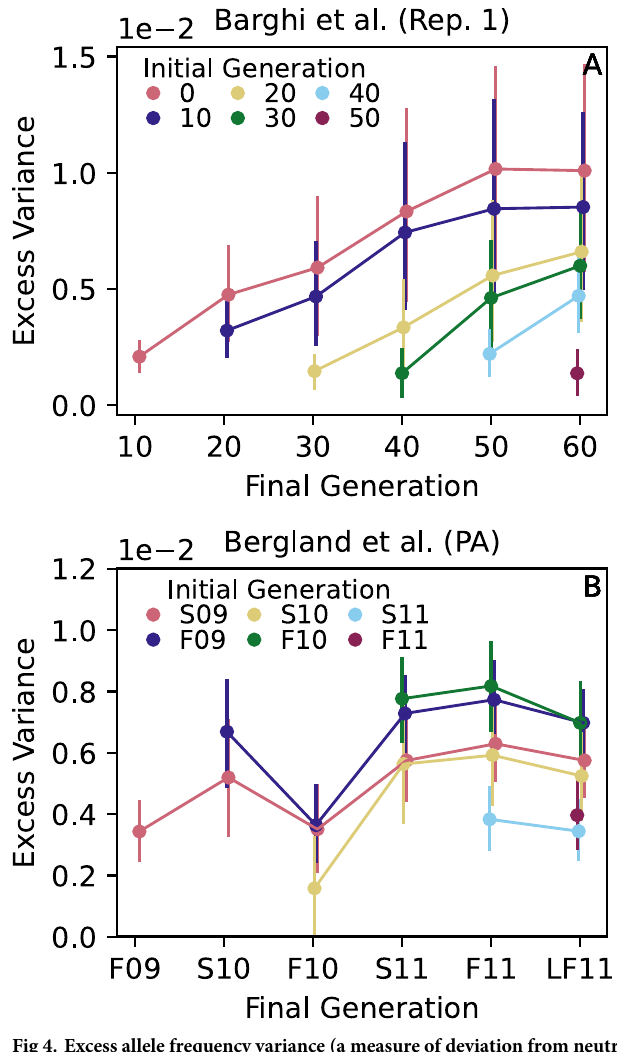
Fig 4. Excess allele frequency variance (a measure of deviation from neutrality defined as C accumulates over time in a D. Simulans E&R experiment (A; [11]), but remains relatively flat in a wild D. Melanogaster population (B; S = Spring, F = Fall, LF = Late Fall; 09 = 2009 etc.; [15]). The excess variance is calculated for intermediate frequency alleles falling within a major allele frequency bin at p = 0.5. In (A), p � = 0.9 and bin width is 2.5%. In (B), p � = 0.8 and bin width is 5%. Vertical lines show 95% block bootstrap confidence intervals (1Mb